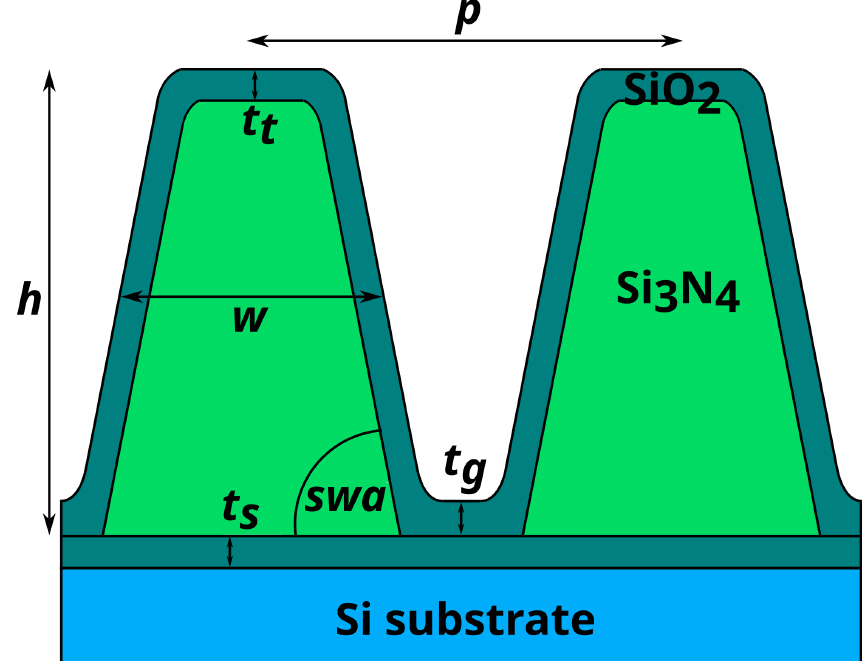
Figure 2. Schematic drawing of the Si 3 N 4 sample. The figure depicts the cross section of two grating lines with the sample parameters used for the